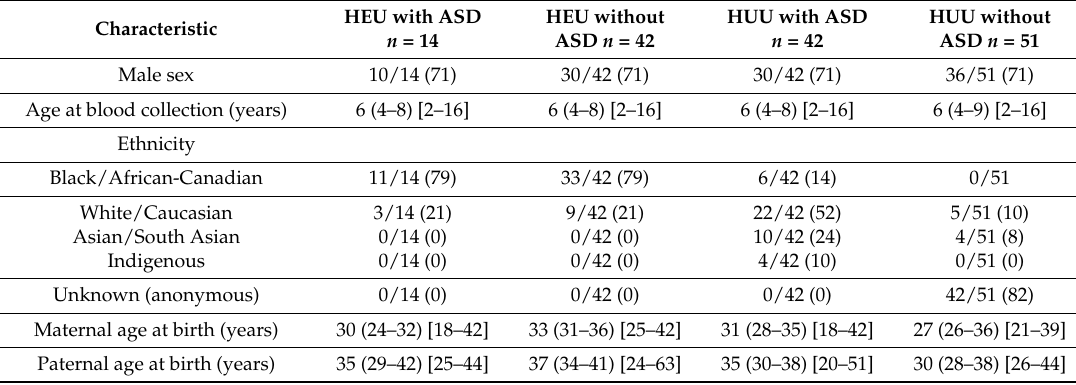
Table 1. Demographic characteristics of the matched study participants (cases and